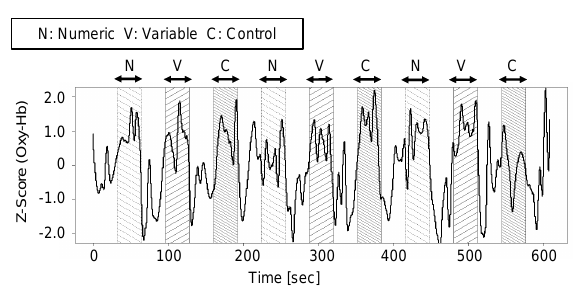
Fig. 11. Reconstruct wave include d 10 and d 11 component.